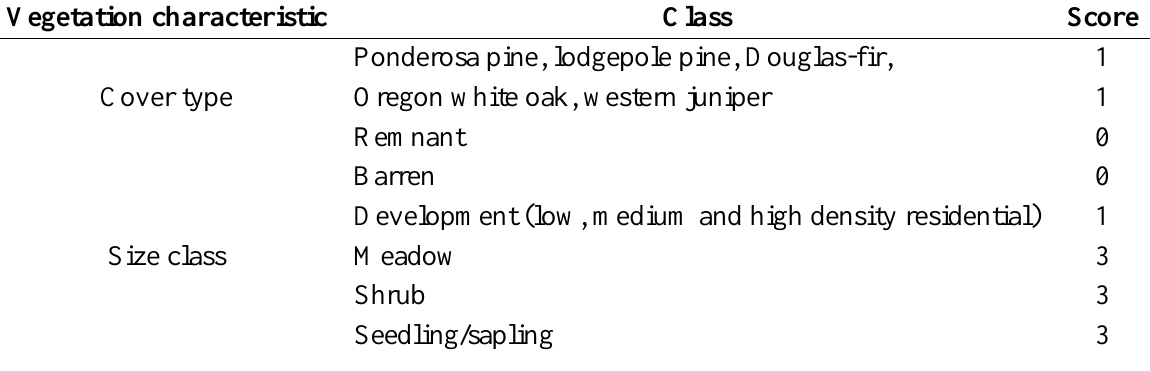
Table A10.3. Habitat model for mule deer: scoring system for hiding habitat. (Note: QMD is quadratic mean